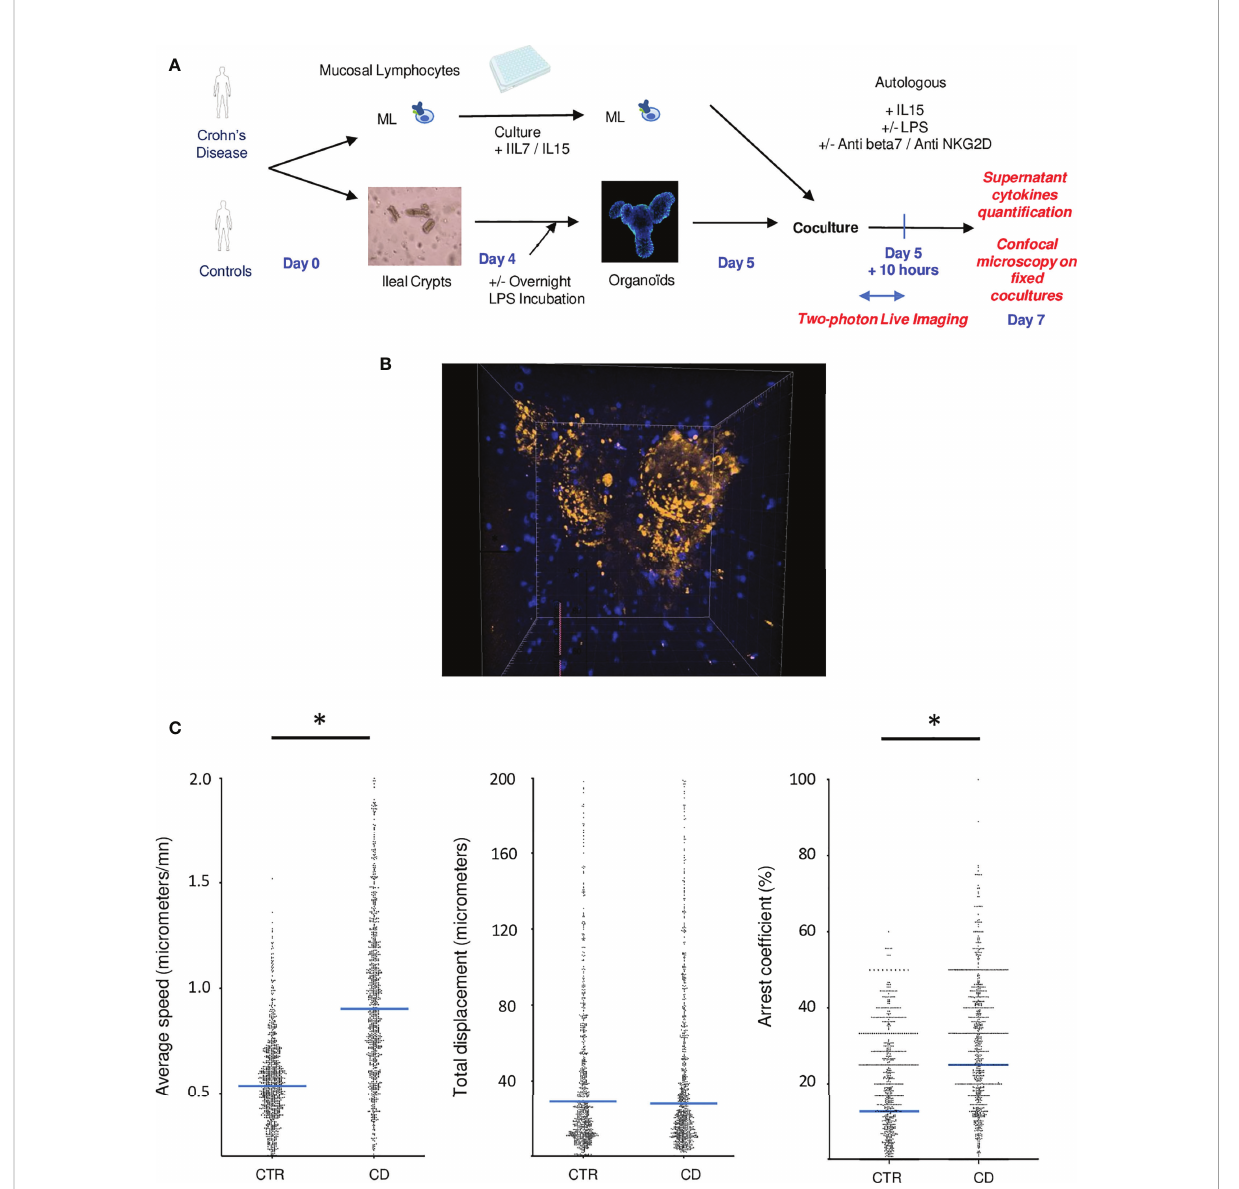
FIGURE 2 Autologous co-cultures reveal direct interactions between mucosal lymphocytes and epithelial organoids especially in CD patients. (A) Experimental design of cocultures (B) Example of a two photon acquisition for a CD patient showing multiple interactions between T cells and an organoid. (C) Average speed, total displacement and arrest coef fi cient of lymphocytes in cocultures. Each dot corresponds to a lymphocyte. Cells from different individuals were combined in this fi gure. These fi gures represent 2 control patients and 3 IBD patients. CD= Crohn ’ s Disease, CTR= Control. *p < 0.05 Mann Whitney